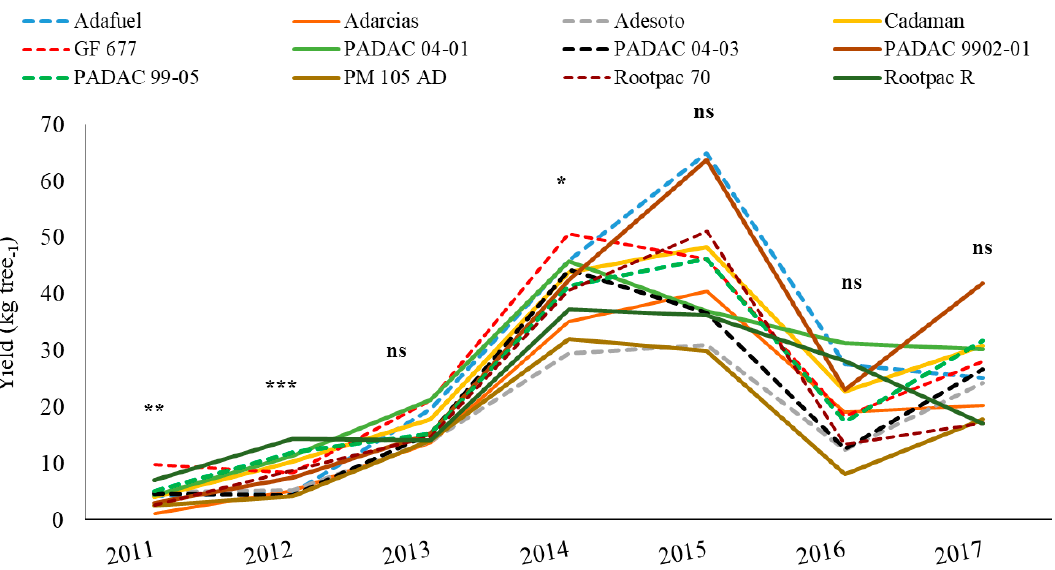
Figure 2. Annual yields (kg tree − 1 ) of “Big Top” nectarine cultivar budded on 12 Prunus rootstocks. The significance is designated by asterisks as follows: *, statistically significant di ff erences at p -value < 0.05; **, statistically significant di ff erences at p value < 0.01; ***, statistically significant di ff erences at p -value < 0.001; ns, not significant.